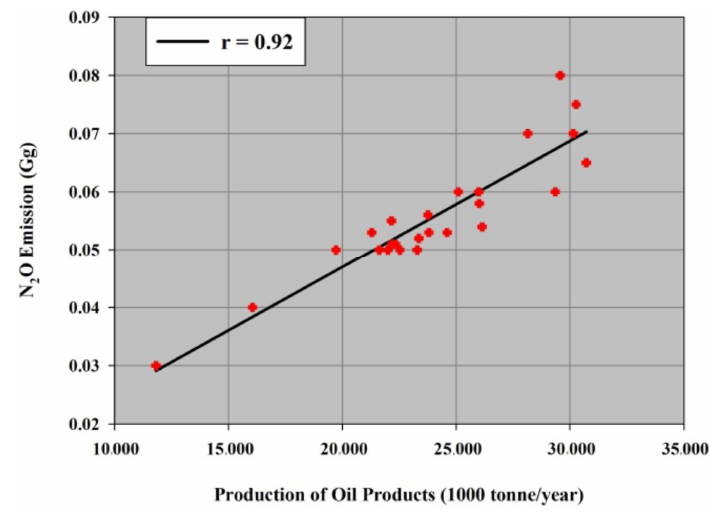
Figure 12. The correlation coefficient between CO 2 , CH 4 , and N 2 O emissions and the production of oil derivatives from the oil refining industry in Iraq.